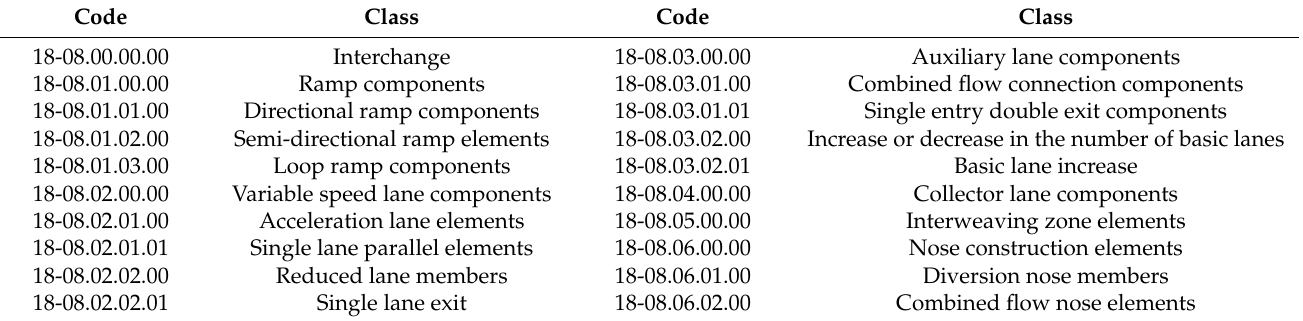
Table 6. Classification and coding of special components for interchanges.